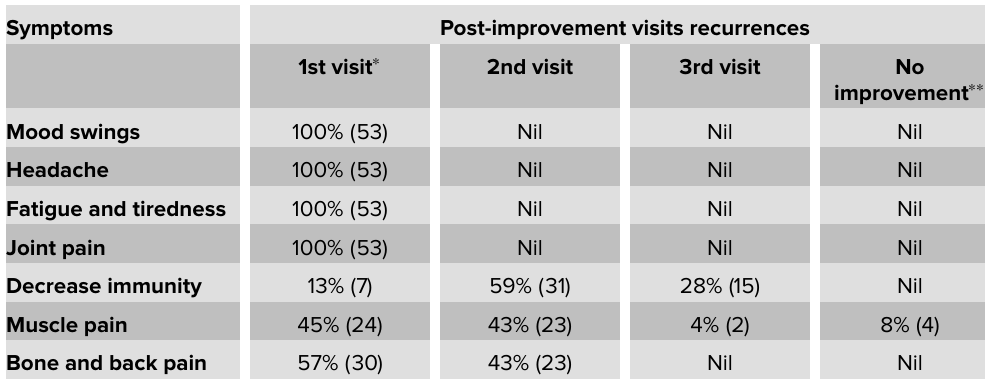
TABLE 4: The percentage of patients’ improvement in mood swings and other somatic symptoms depending on the recurrent visits to the doctor post